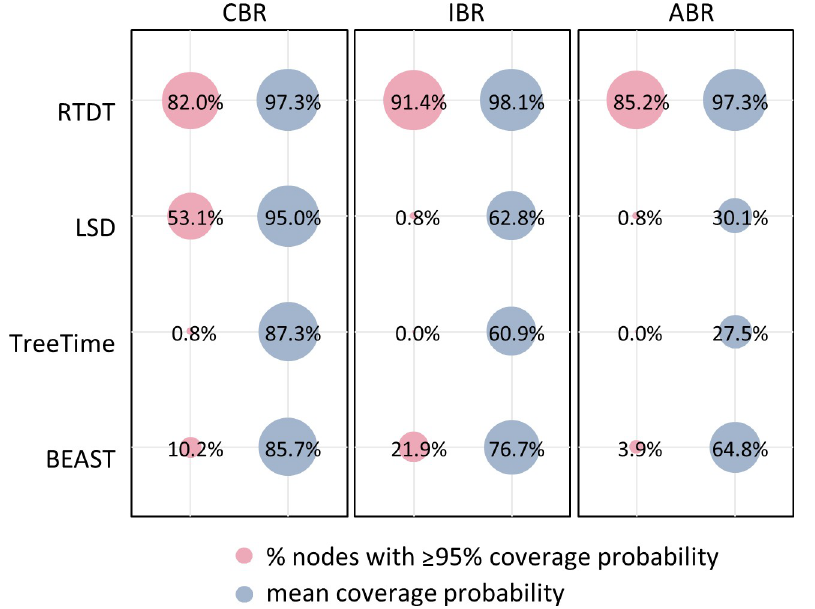
Fig 4. The proportion of nodes with � 95% coverage probabilities and mean of coverage probability of CIs or HPDs for computer-simulated datasets of HIV-1 subtype F. The proportion of nodes with � 95% coverage probability is the proportion of nodes in which � 95% of CIs and HPDs contained the actual times, and mean coverage probability is the mean proportion of CIs and HPDs that contained the actual times across the nodes. The model tree is presented in Fig 2 . There were 50 simulated datasets (replicates) for each of the CBR, IBR, and ABR datasets. Therefore, each node had 50 CIs or HPDs to compute the coverage probability of a node. We did not use treedater because it does not produce